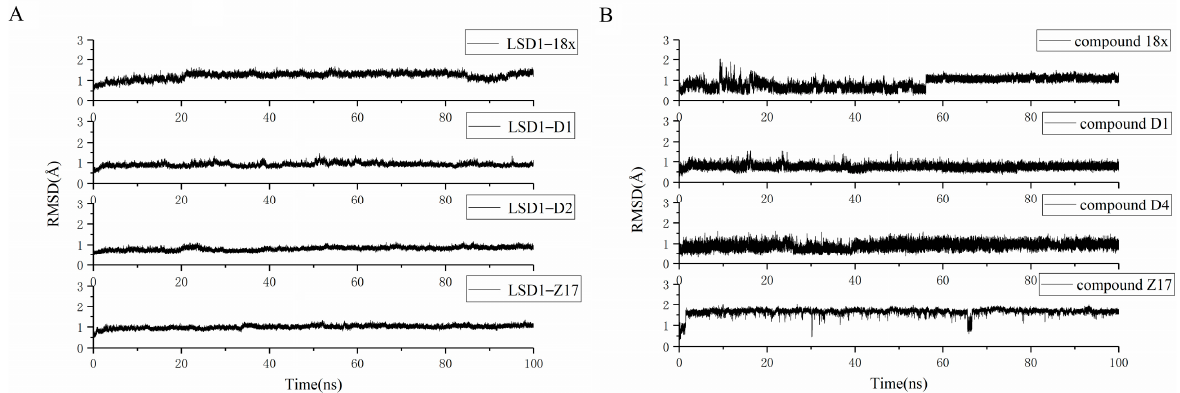
Figure 6. The RMSD results of the four systems. ( A ) The RMSD values of the complexes in the four systems. ( B ) The RMSD values of the ligands in the four systems. Figure 7 indicates that the superposition of the docking structure and MD average structure during MD equilibrium stage for each system. It was worth noting that the four compounds are still located well in the substrate binding region, which share the same binding mode with a “U-shaped” conformation. Furthermore, the hydrophobic and